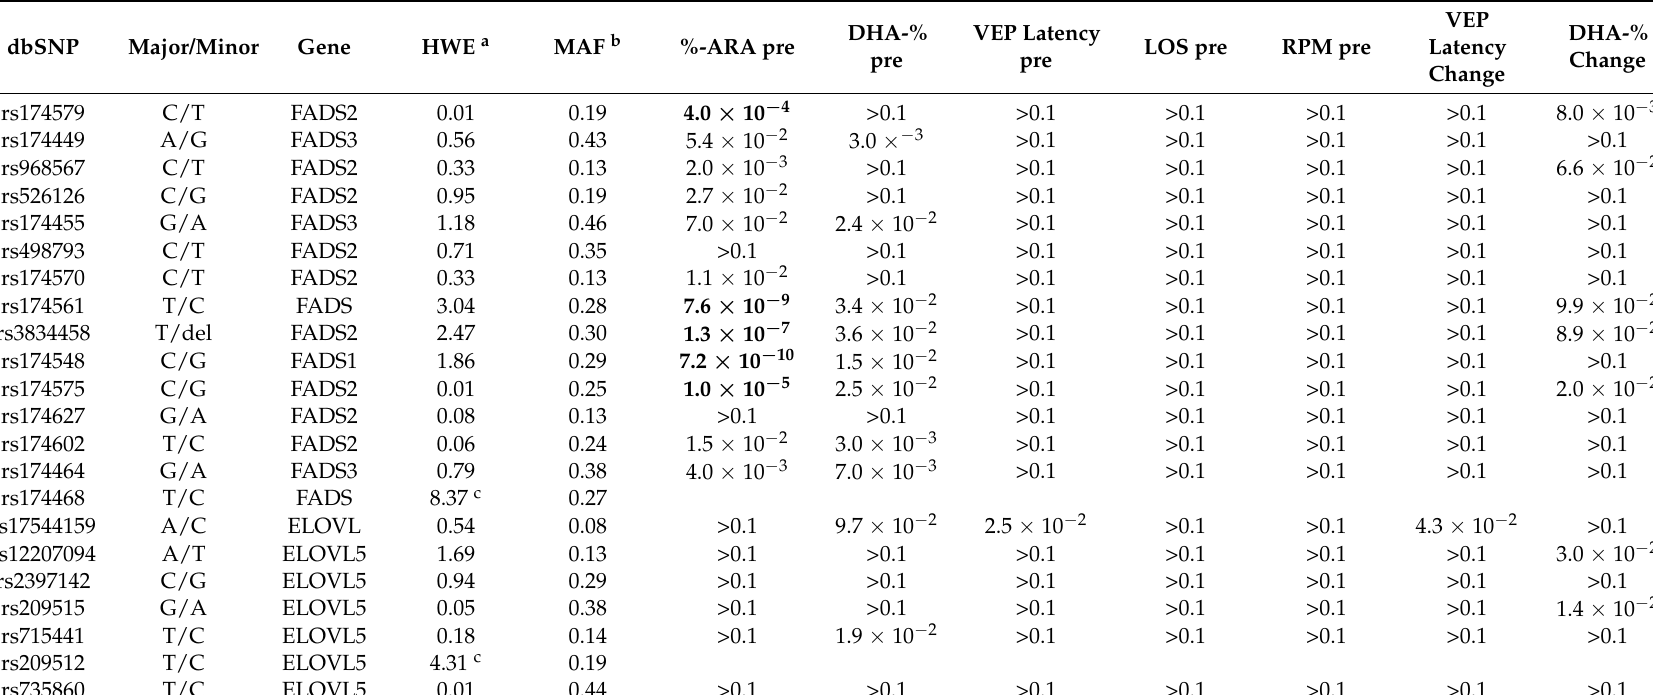
Table 4. SNPs considered in the genetic analyses and significance of their influence on pre study ARA-%, DHA-%, VEP latency, LOS T-score, RPM score, and change of DHA and VEP latency; statistically significant effects ( p < 0.00045, considering Bonferroni adjustment are printed in bold, n =